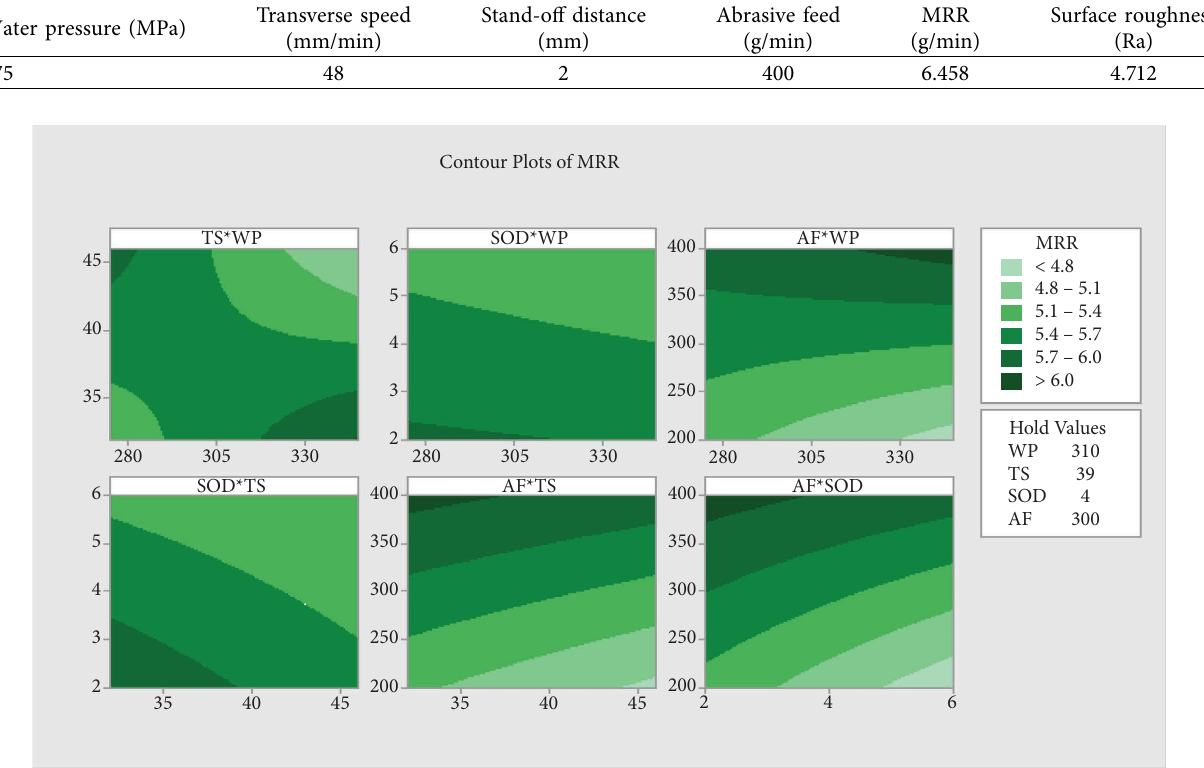
Table 3: Abrasive water jet cutting optimized results of AA5083 by